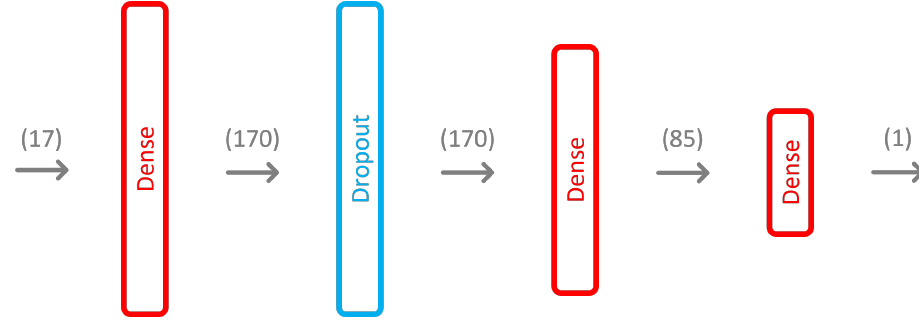
Figure 6. Iterative model’s